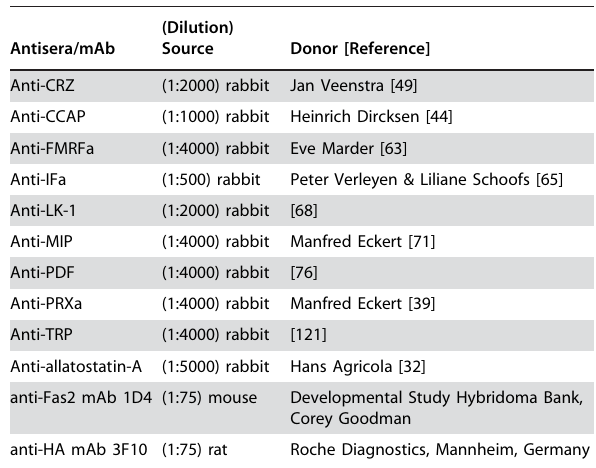
Table 3. Peptidergic projections in relation to Fas2 tracts Assignment of putative main compartment identities as suggested by morphology, immunolabeling intensities